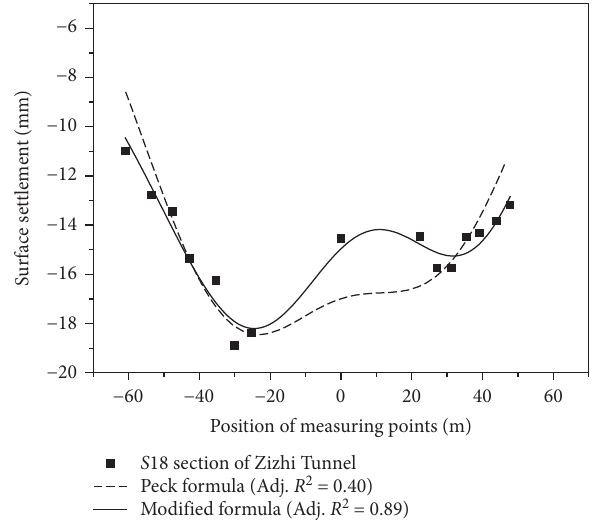
Figure 10: Surface settlement of S 18 section inside the river-af- fected area.